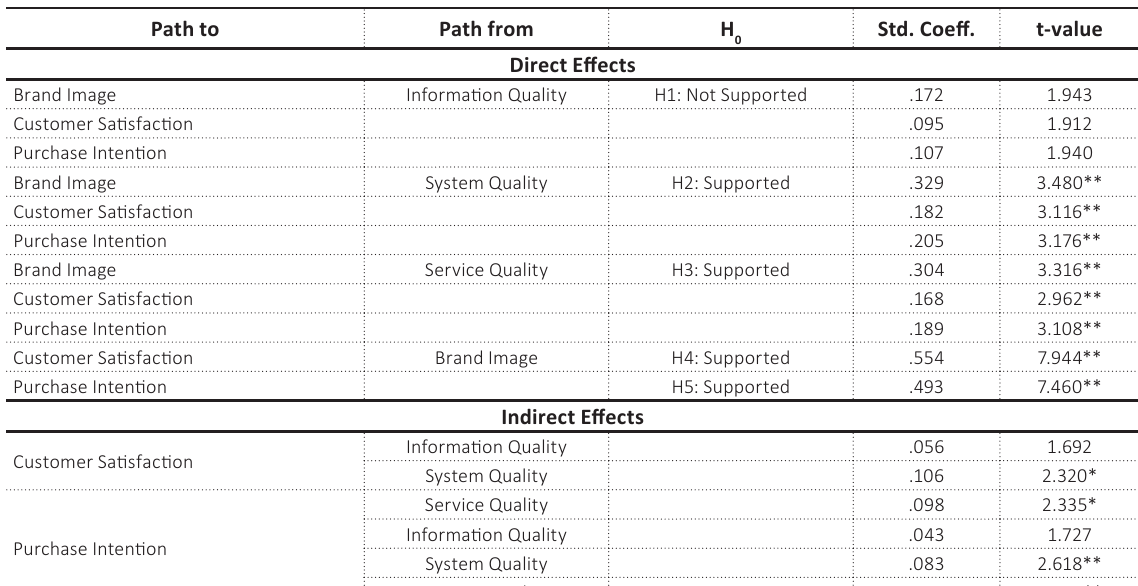
Table 4. Results of path